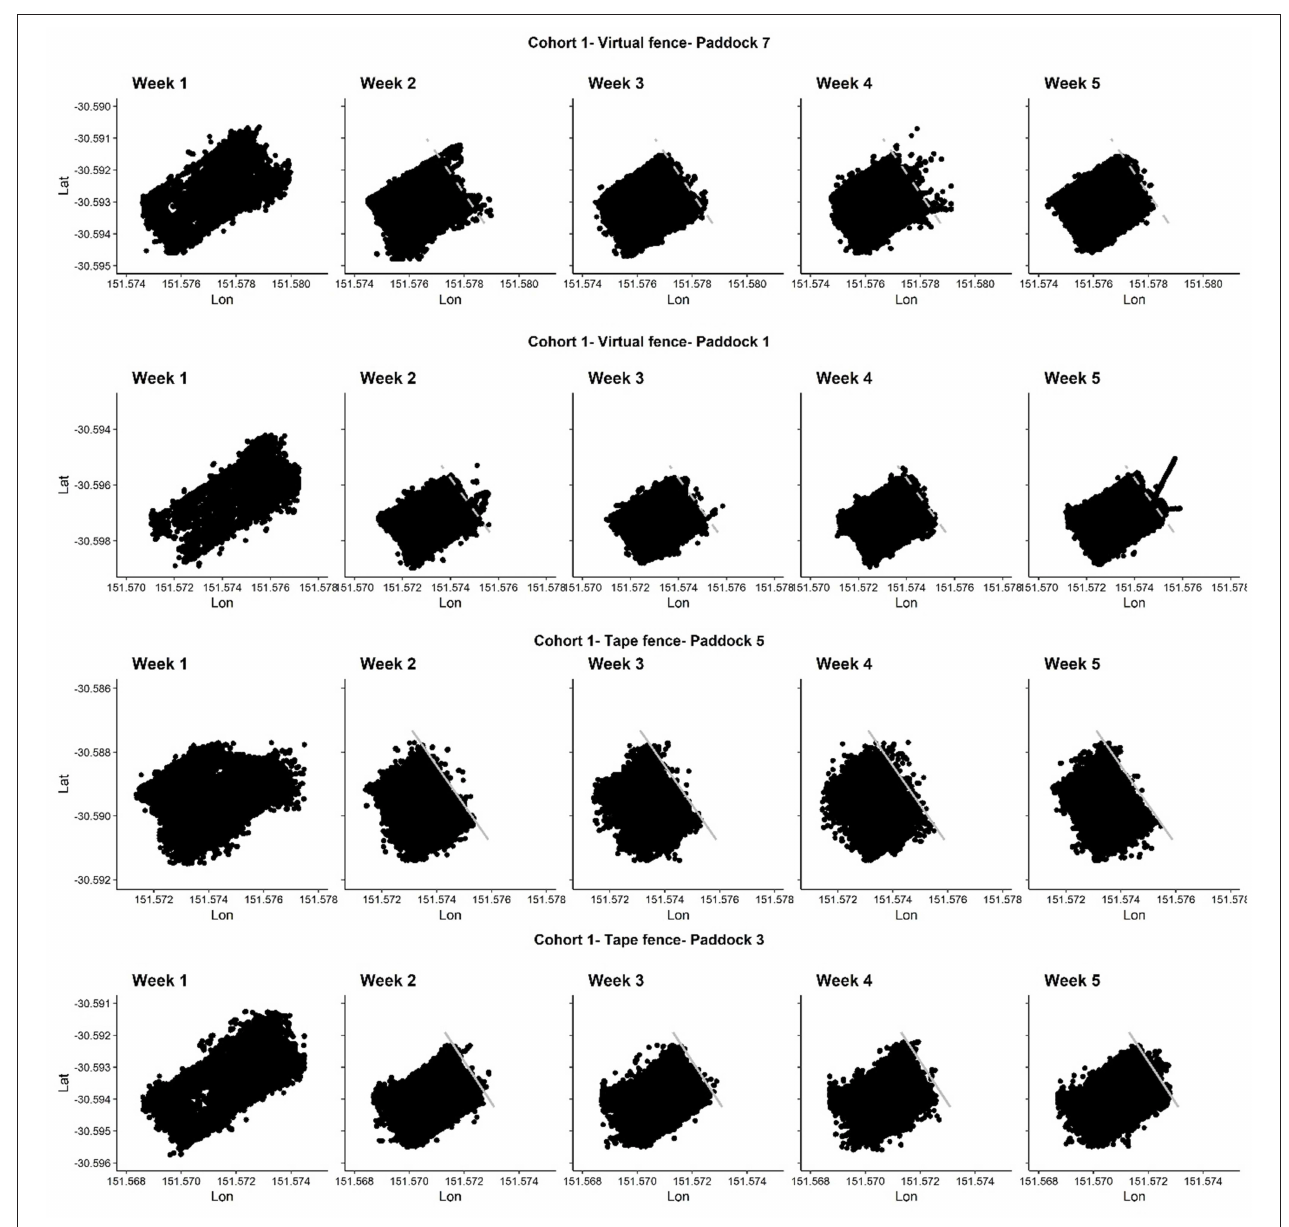
FIGURE 3 | The GPS locations (latitude and longitude) of four cattle groups in cohort 1 across each week of the trial. An electric tape fence (solid lines) or a virtual fence (dashed lines) was placed/activated at the beginning of week 2. The fence type and paddock number (as related to Figure 1 ) is indicated. On week 2 in paddocks 1 and 7 cattle did cross over the virtual lines as they were learning the cues. Dots are GPS locations of individual cattle that were recorded every second when the animals were within a specified distance (value commercial in confidence) from the virtual fence line and/or walking/grazing. The shape of the GPS dots aligns with the shape of the paddocks as per Figure 1 indicating cattle used all available areas during week 1 and were subsequently restricted by the fence. Dots outside of the paddock boundaries indicate typical GPS error. In week 5 in paddock 3, an animal pushed under the electric tape twice due to a short in the